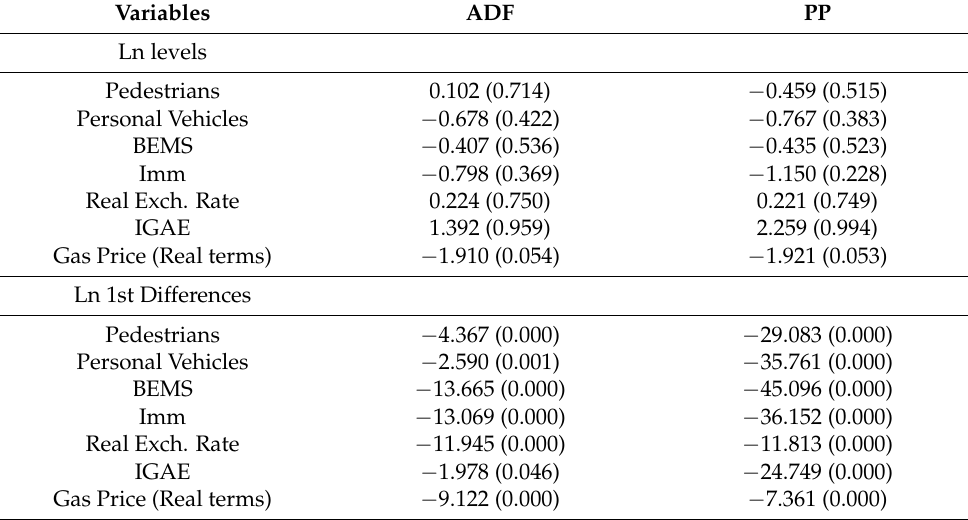
Table 4. Unit root tests.